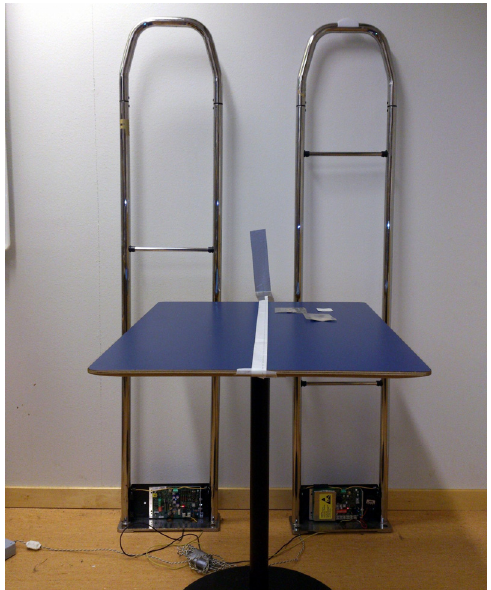
Figure 11. EAS detection gate setup where the gates have been turned side by side to test the reading range of EAS tags positioned in front of the